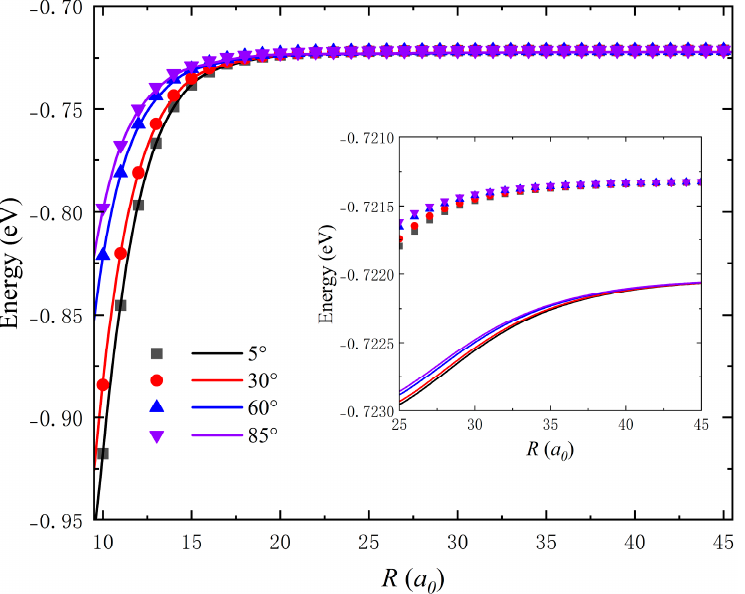
Figure 6. Long − range interaction potentials obtained on the GP PES along the radial coordinate at four fixed Jacobi angles ( θ = 5°, 30°, 60° and 85°) with the bond length of Na 2 fixed at 6.01 a 0 , in four fixed Jacobi angles ( θ = 5 ◦ , 30 ◦ , 60 ◦ and 85 ◦ ) with the bond length of Na 2 fixed at 6.01 a 0 , in comparison with the original ab initio energies. comparison with the original ab initio